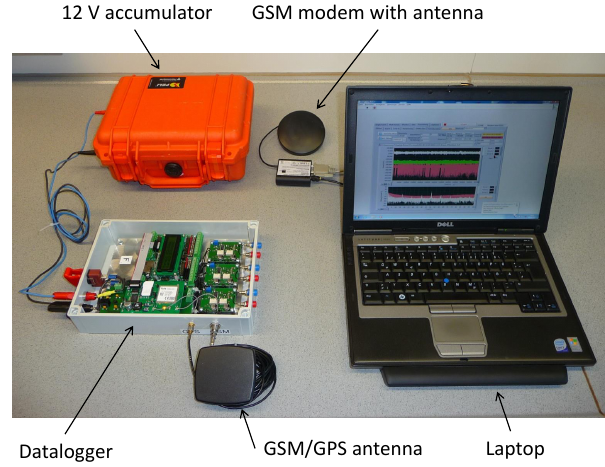
and 12V accumulator. A laptop with GSM modem and antenna for remote